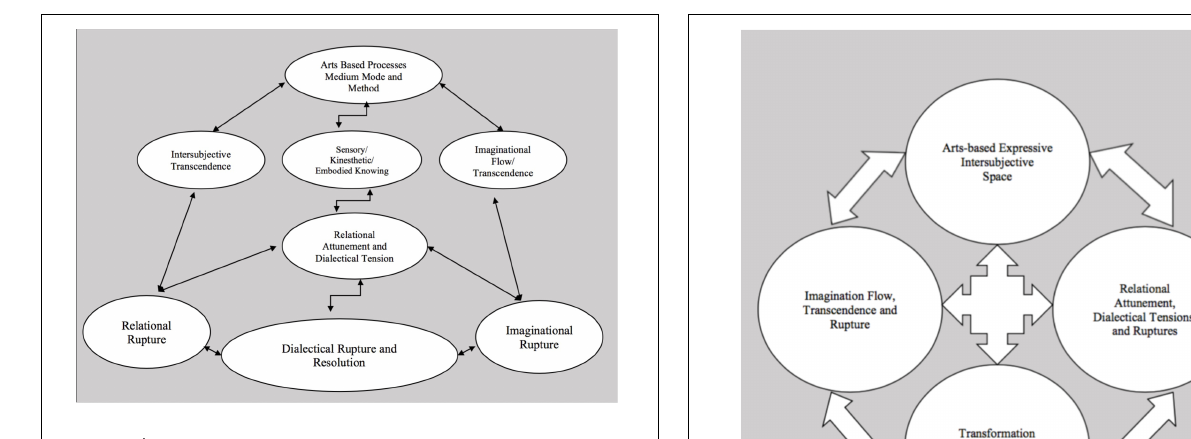
FIGURE 1 | Kinetic mobile system for dynamic change.